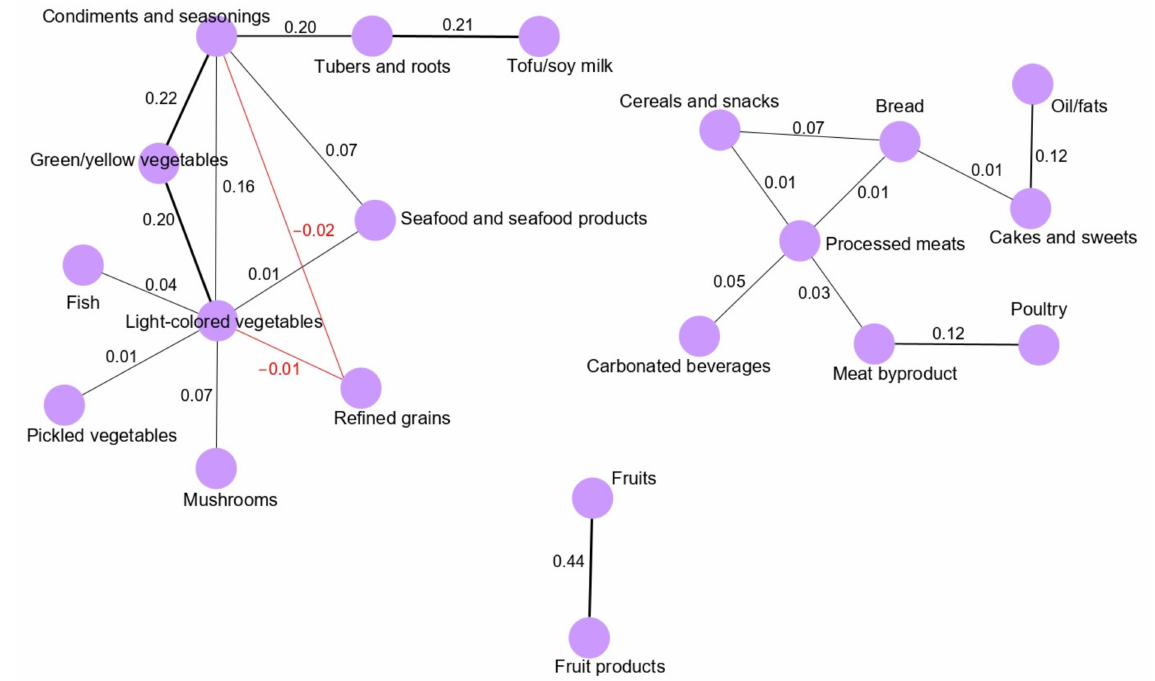
Figure 2. Dietary intake networks for the male population derived from GGM. Nodes represent the food group variables, and edges represent the conditional dependencies reflected by partial correlation coefficients between food groups. Black lines indicate positive partial correlation coefficients, while red lines represent negative partial correlation coefficients. The thickness of the edge is proportional to the strengths of the correlation between food groups. The absence of an edge between two food groups indicates conditional independence.